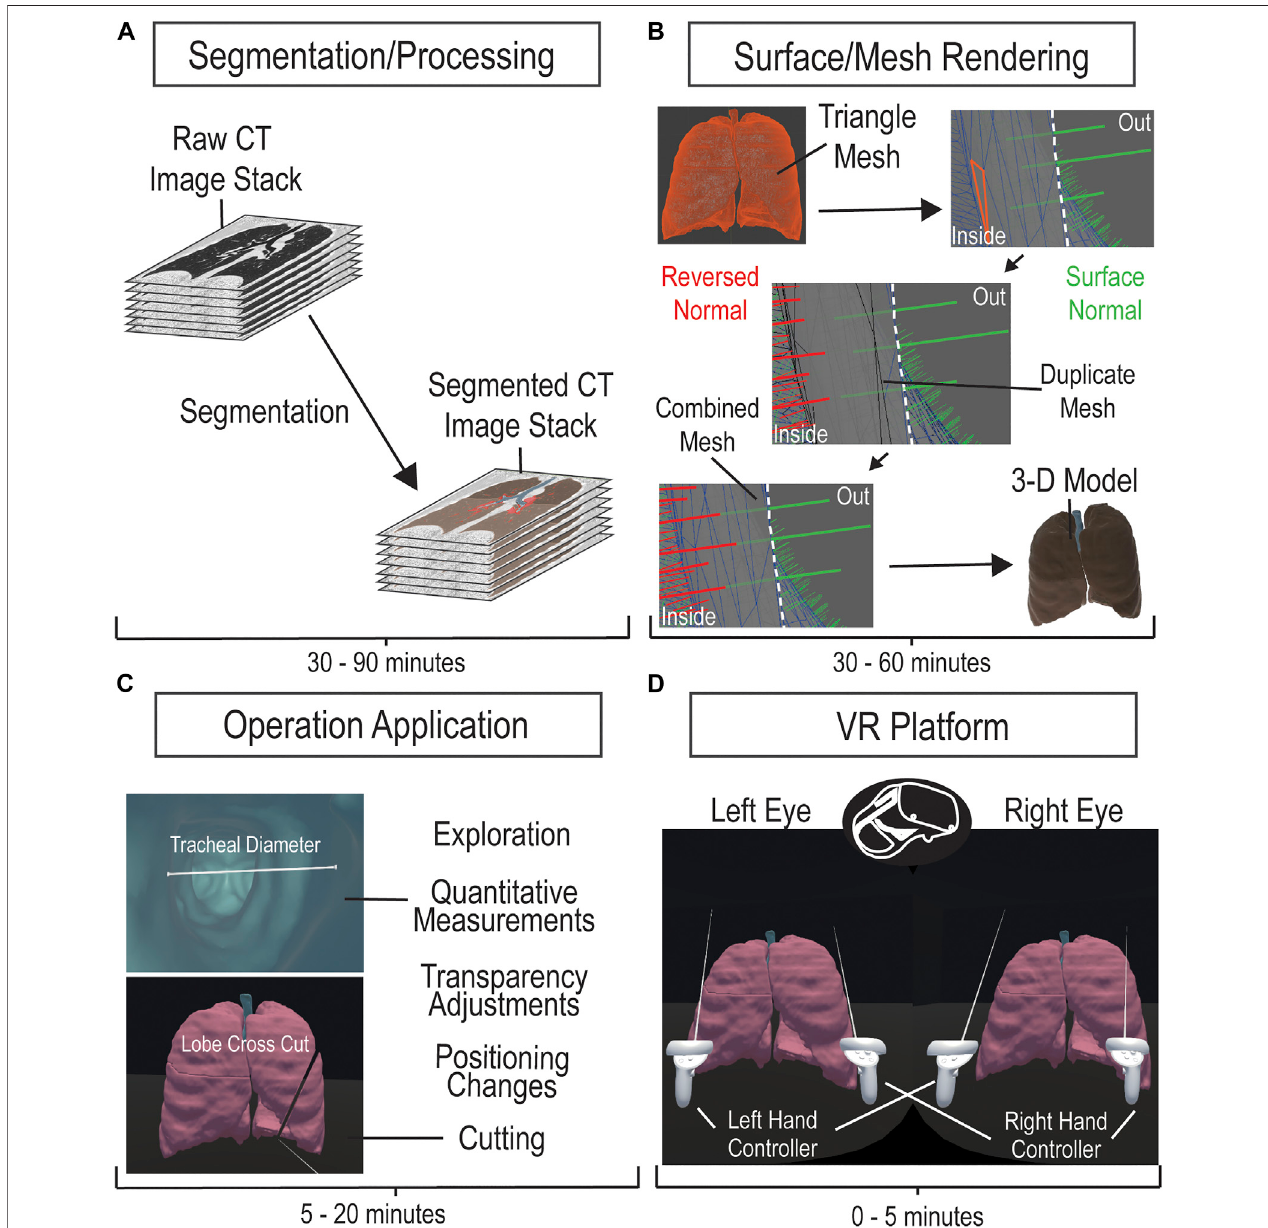
FIGURE1| CTImagingtoVRFrameworkPipeline.Afour-stepprocesstodevelop aVRplatformforviewingCTimages. AcquiredCTimage stacksareprocessed and segmented over 30 – 90 min (A) to generate a mesh surface (B) . The mesh surface normals are manipulated to properly generate a 3-D surface model using Maya within 30 – 60 min (B) . The model is loaded onto the VR platform and is applied with the corresponding manipulation scripts (C) . The VR platform generates an environment that allows the user to interactively explore and manipulate the 3-D model (D) .